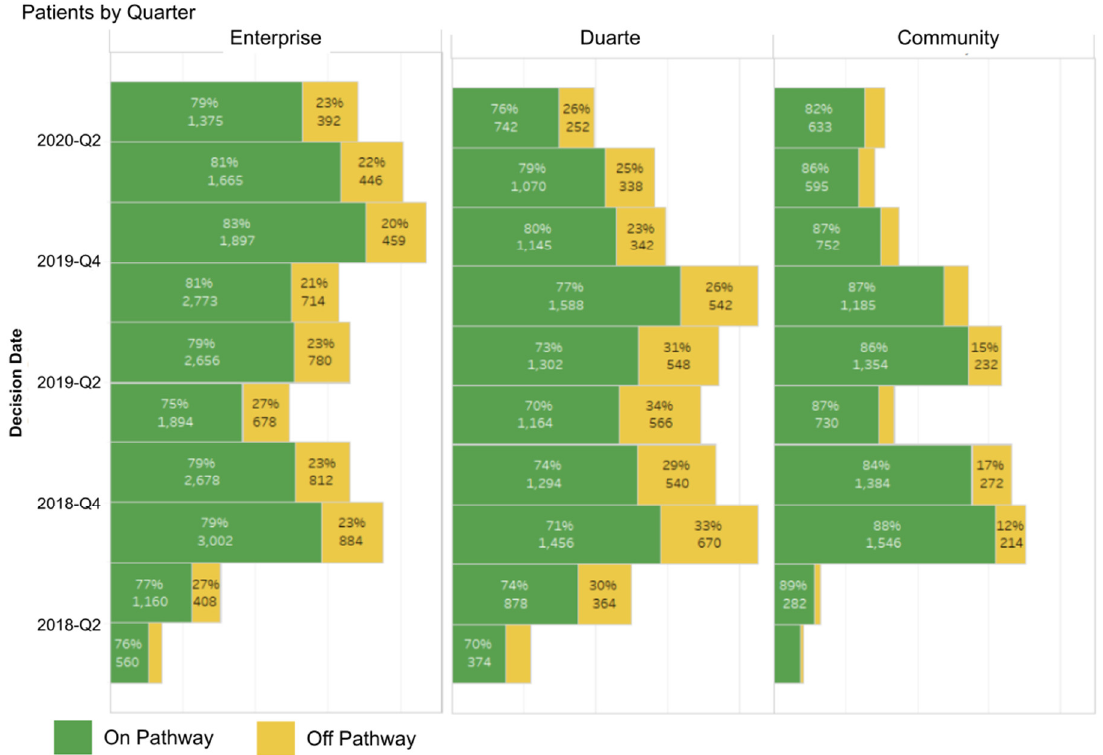
Figure 5. Pathway compliance percentage over time for medical oncology patients navigated in pathway tool (ClinPath) for enterprise, Duarte academic campus, and community sites for new therapy regimens ordered in the EPIC-BEACON EHR from January 2019 through June of 2020. Green bars are on-pathway choices (including clinical trials) and yellow bars are off-pathway choices. Note that the scale of the x-axis representing the numbers of patients is different for each group to show the comparison percentages in one graph. The combined number of patients navigated in Duarte and community sites is reflected in the number totals described on the enterprise graph.